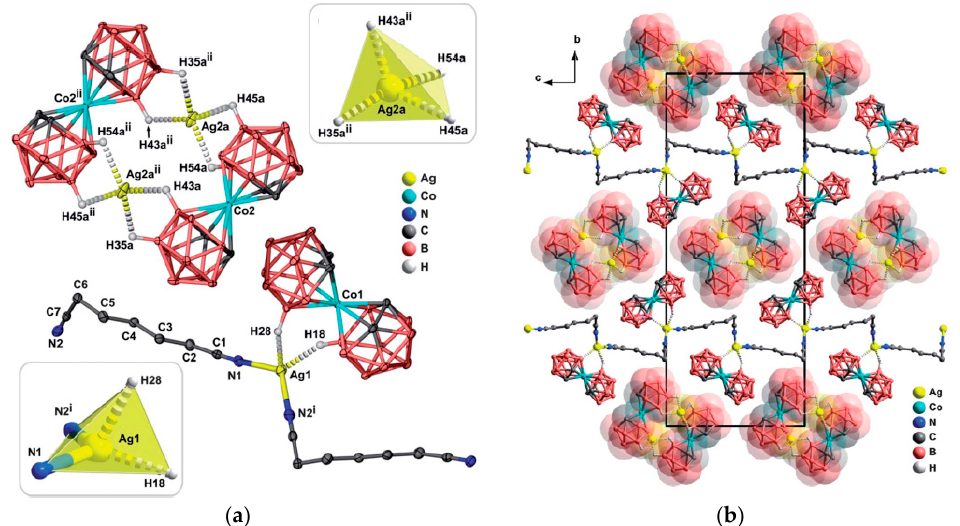
Figure 106. X-ray structure of {((NC(CH 2 ) 5 CN)Ag)[3,3’-Co(1,2-C 2 B 9 H 11 ) 2 ](Ag[3,3’-Co(1,2-C 2 B 9 H 11 ) 2 ])} n : coordination arrangement of silver cation ( a ) and crystal packing ( b ). Reproduced from reference [123] with permission from The Royal Society of Chemistry.